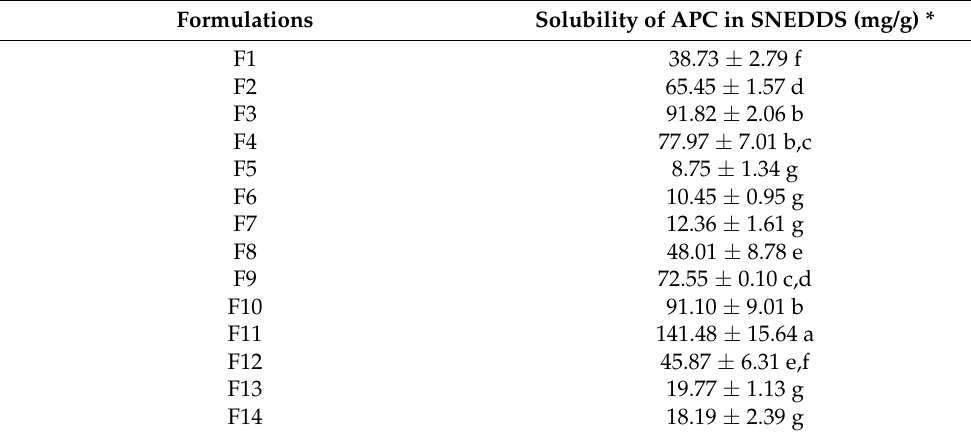
Table 4. Solubility of APC in SNEDDS